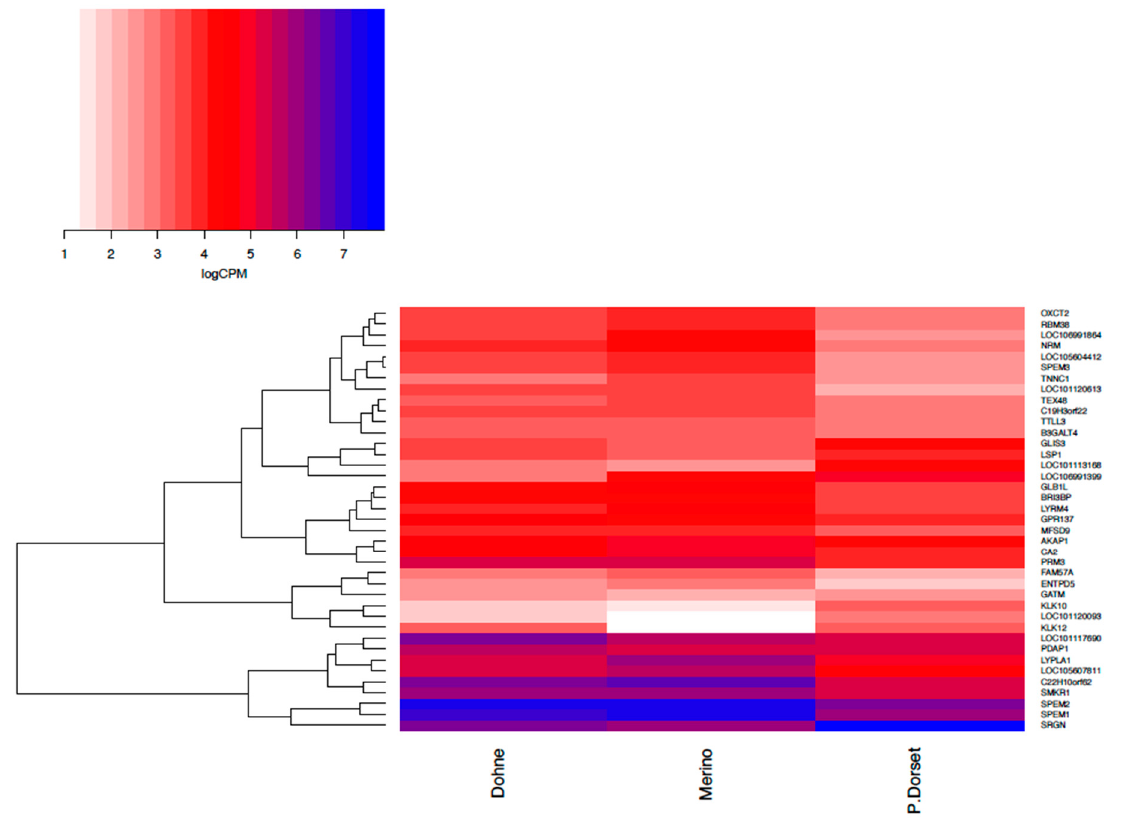
Figure 2. Cluster heat map comparing differentially expressed genes between sampling groups: Dohne, Merino, and Poll Dorset rams.